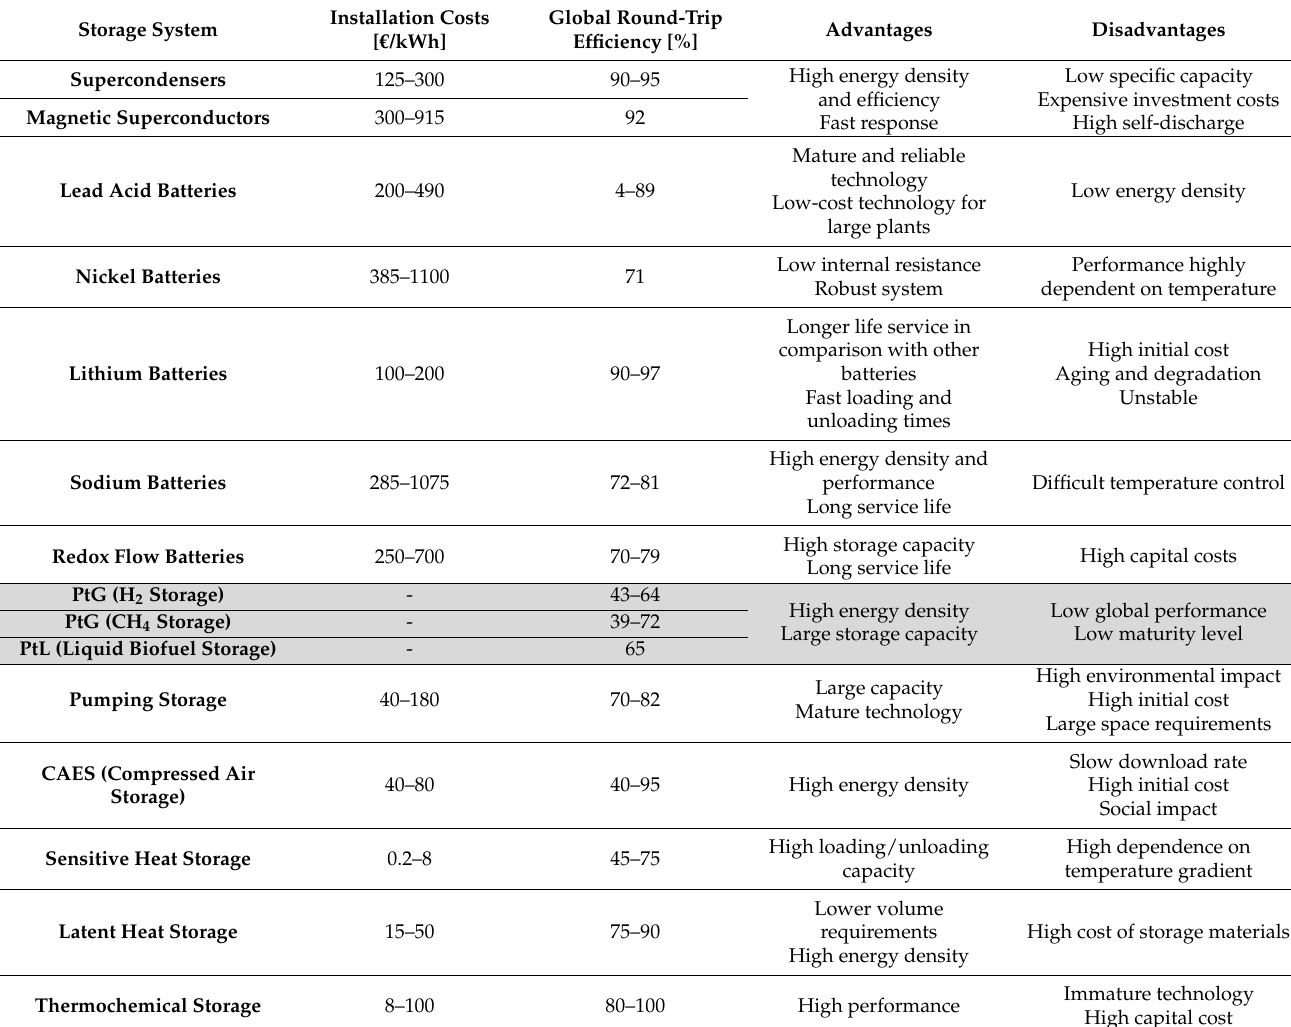
Table 5. Energy Storage technologies, adapted from